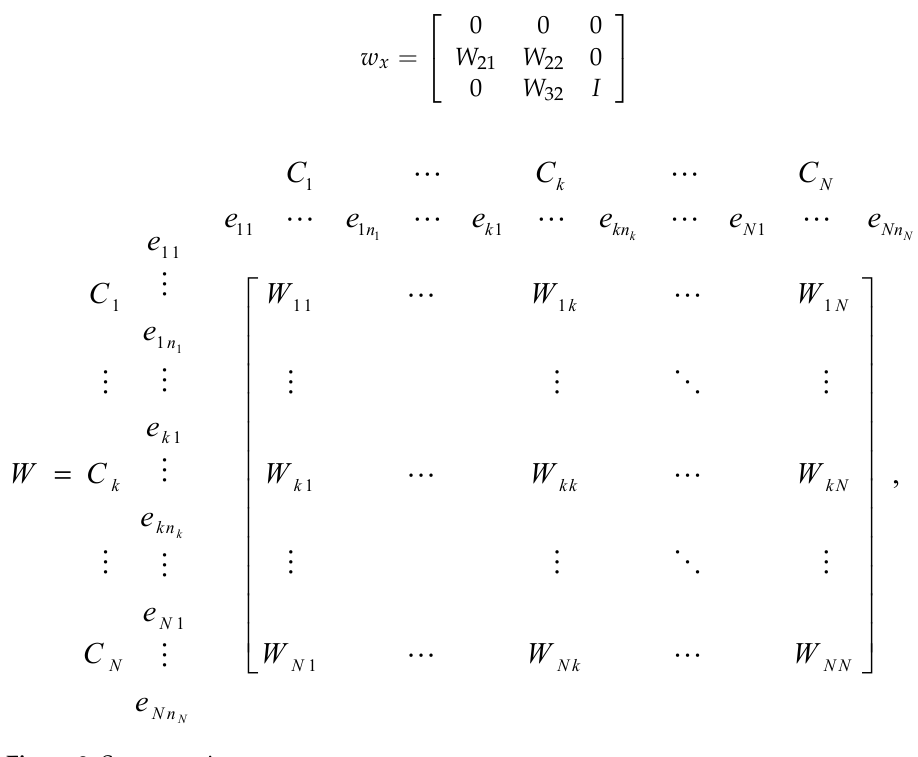
Figure 2. Supermatrix.